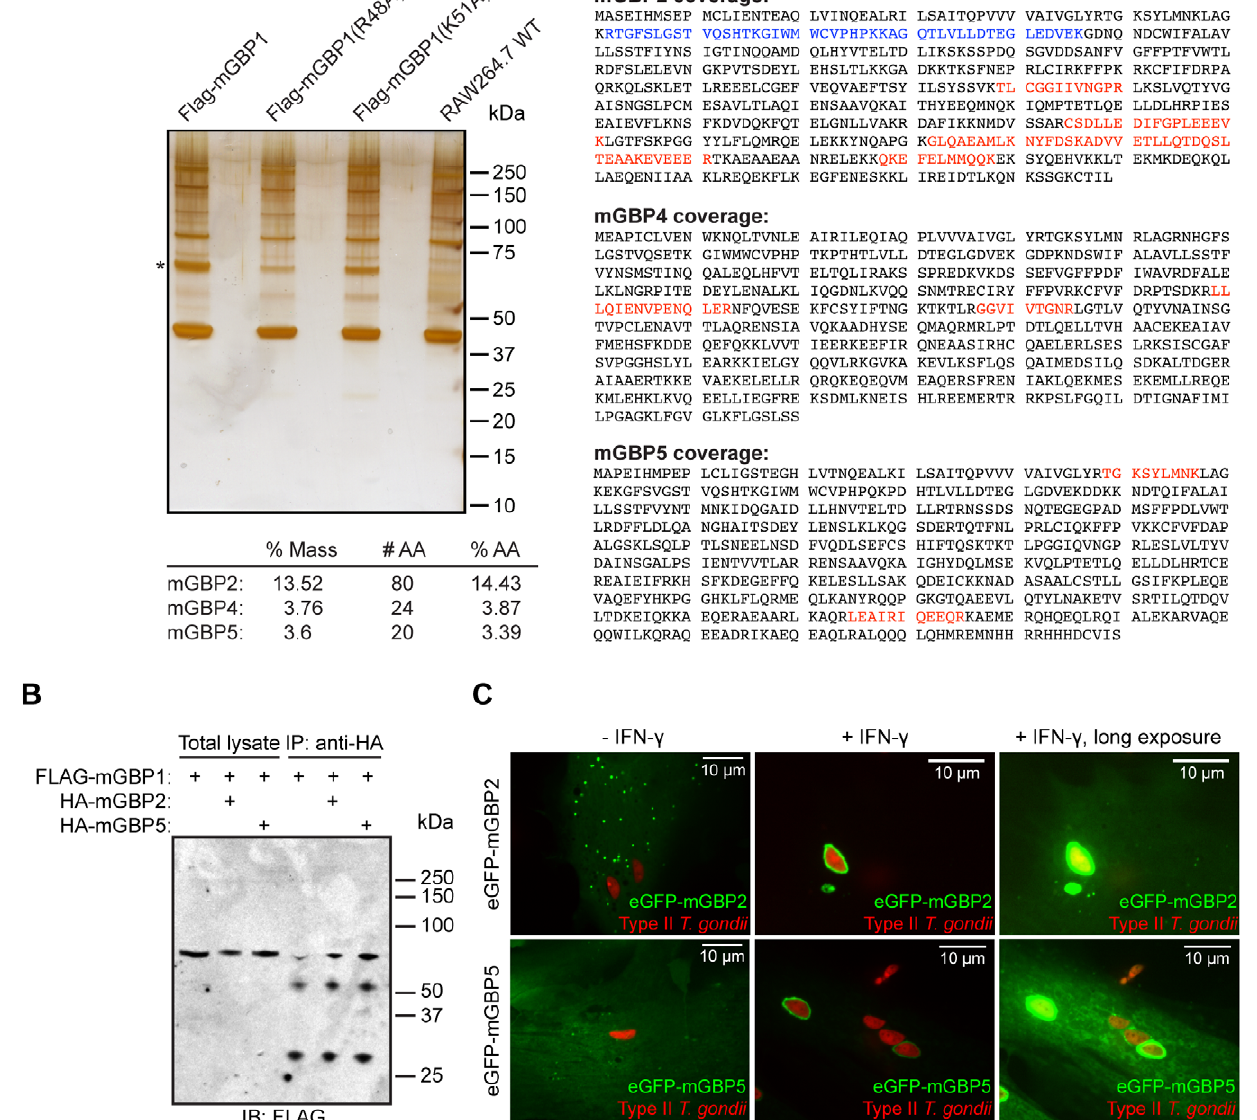
Figure 4. mGBP2 and mGBP5 interact with mGBP1 and accumulate on type II T.gondii (Pru) vacuoles. (A) mGBP2, mGBP4, and mGBP5 were identified as interactors of mGBP1 in a immunoprecipitation with subsequent MS/MS analysis (A). The left panel shows a silver-stained SDS- PAGE gel following an anti-FLAG IP from wild-type RAW264.7 cells (control lane) or RAW264.7 that overexpress wild-type or various mGBP1 mutants. The right panel shows three GBPs that were identified in the mass spectrometry analysis as binding partners of mGBP1. Wild-type RAW264.7 cells or RAW264.7 cells that overexpress FLAG-mGBP1, FLAG-mGBP1(R48A) or FLAG-mGBP1(K51A) were stimulated with 200 U/ml IFN- c overnight and infected with type II T. gondii at an MOI of 5–10 for 1 h. The mGBP1 protein was recovered from all lanes except from the control lane (*). Unique peptides recovered from mGBP2, mGBP4, and mGBP5 are shown in red and peptides common with mGBP1 are shown in blue. The total number of unique amino acids ( # AA), the percentage of total mass (% Mass), and the percentage of total amino acids (% AA) recovered are also shown. For mGBP4 and mGBP5, the sequence coverage was 3–4%. 14% of the mGBP2-specific amino acids were found in the gel (21% when including amino acids common to mGBP1). (B) Interaction of HA-mGBP2 and HA-mGBP5 with FLAG-mGBP1 was confirmed by co-IP with subsequent immunoblot analysis. RAW264.7 cells that overexpress either FLAG-mGBP1 and HA-mGBP2, FLAG-mGBP1 and HA-mGBP5, or FLAG-mGBP1 alone were lysed in 0.5% NP-40 and proteins were immunoprecipitated with an anti-HA antibody. Co-IP of FLAG-mGBP1 was confirmed by immunoblot with an anti- FLAG antibody. A mouse monoclonal anti-FLAG antibody (Sigma-Aldrich) and a rat monoclonal anti-HA antibody (Roche Applied Science) were used. (C) mGBP2 and mGBP5 are recruited to type II T. gondii vacuoles in an IFN- c dependent manner. Confocal pictures show MEFs that overexpress either eGFP-mGBP2 or eGFP-mGBP5 pre-induced with 200 U/ml IFN- c and infected with type II T. gondii . Live imaging was performed with a spinning disk confocal microscope and revealed that both mGBP2 and mGBP5 were targeted to T. gondii vacuoles in an IFN- c -dependent manner. doi:10.1371/journal.pone.0024434.g004 was immunoprecipitated or in the wild-type control lane. To tagged mGBP2 or mGBP5. IFN- c -stimulated cells that were confirm the observed interactions, we generated RAW264.7 cells immunoprecipitated with anti-HA antibody, showed a FLAG- that overexpressed FLAG-tagged mGBP1 as well as either HA- reactive band by immunoblotting at the right molecular weight of